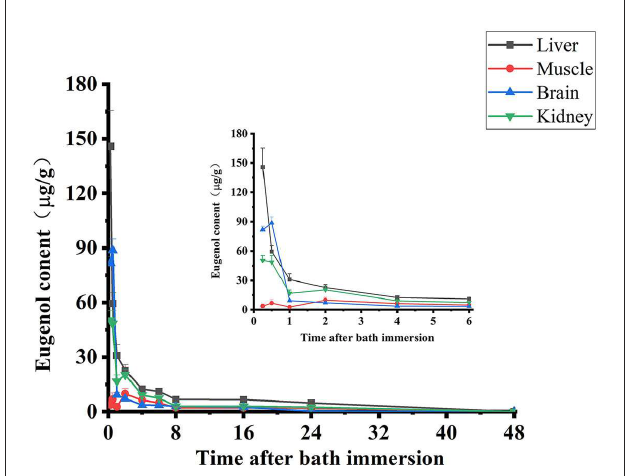
FIGURE3 Concentration-time curves of eugenol in carp muscle, liver, kidney, and brain following a 35 mg/L eugenol of immersion bath ( n =